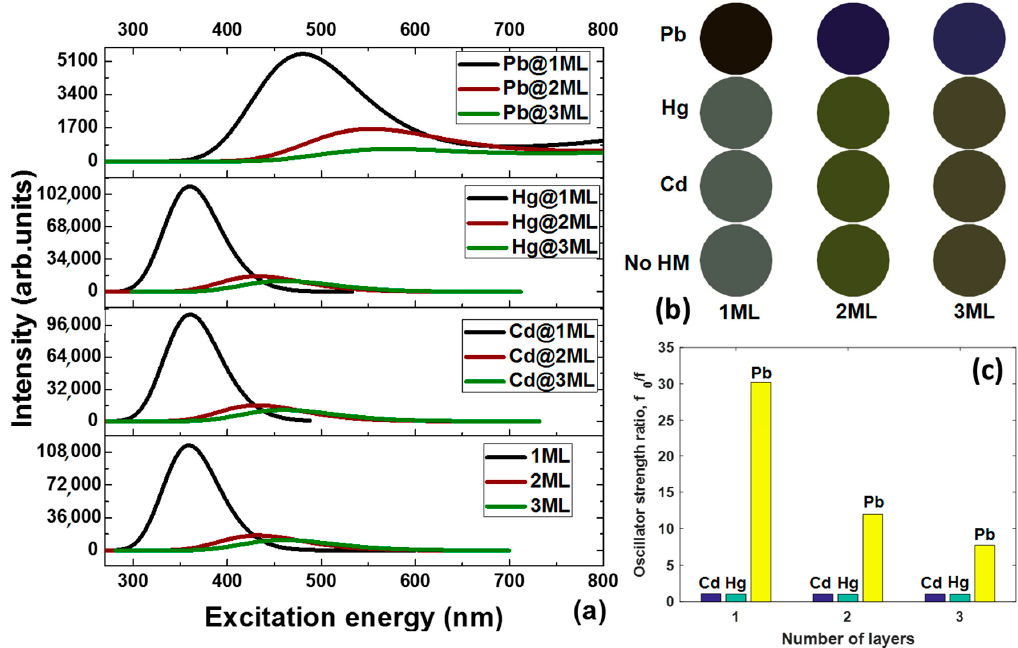
Figure 2. ( a ) Absorption spectra of the monolayer, bilayer, and trilayer GQDs interacting with Cd, Hg, and Pb, obtained from direct gas-phase time-dependent density functional theory (TD-DFT) calculations. ( b ) Palette of the perceived colours of thickness-varying GQDs before and after